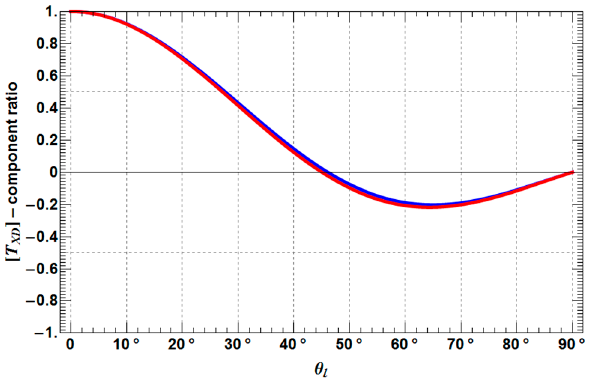
Figure 21. Sensitivity of ( T XD22 − T XD33 )/( T XD22 + T XD33 ) with roughness angle θ 1 (blue) ( ε s = 20, ε t = 30, ω l = 30 ◦ , φ = 0 ◦ ) and comparison with sinc (4 θ 1 ) (red).